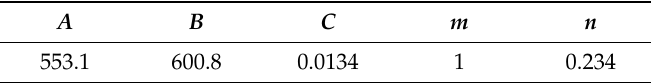
Table 4. Johnson–Cook coe ffi cients of AISI 1045 steel.